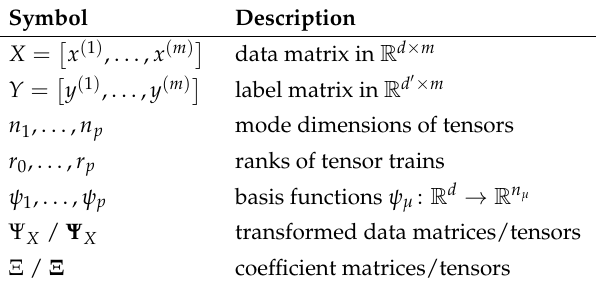
Table 1. Notation used in this work.